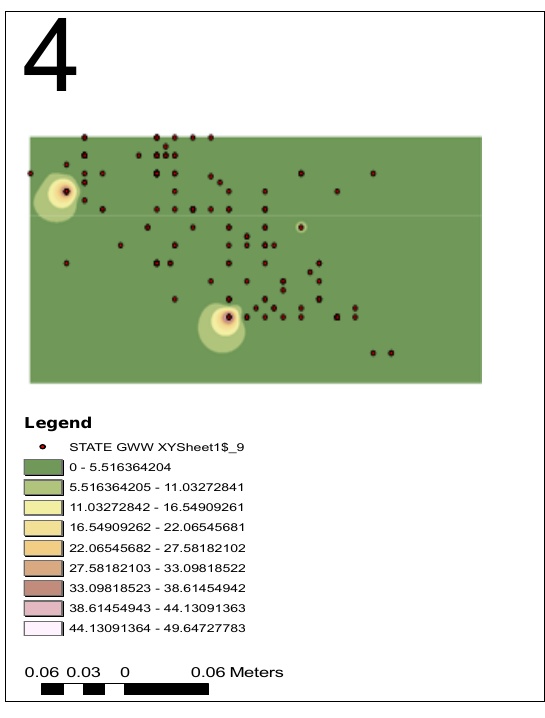
Fig (12)Potable and non Potable Wells spacial distribution